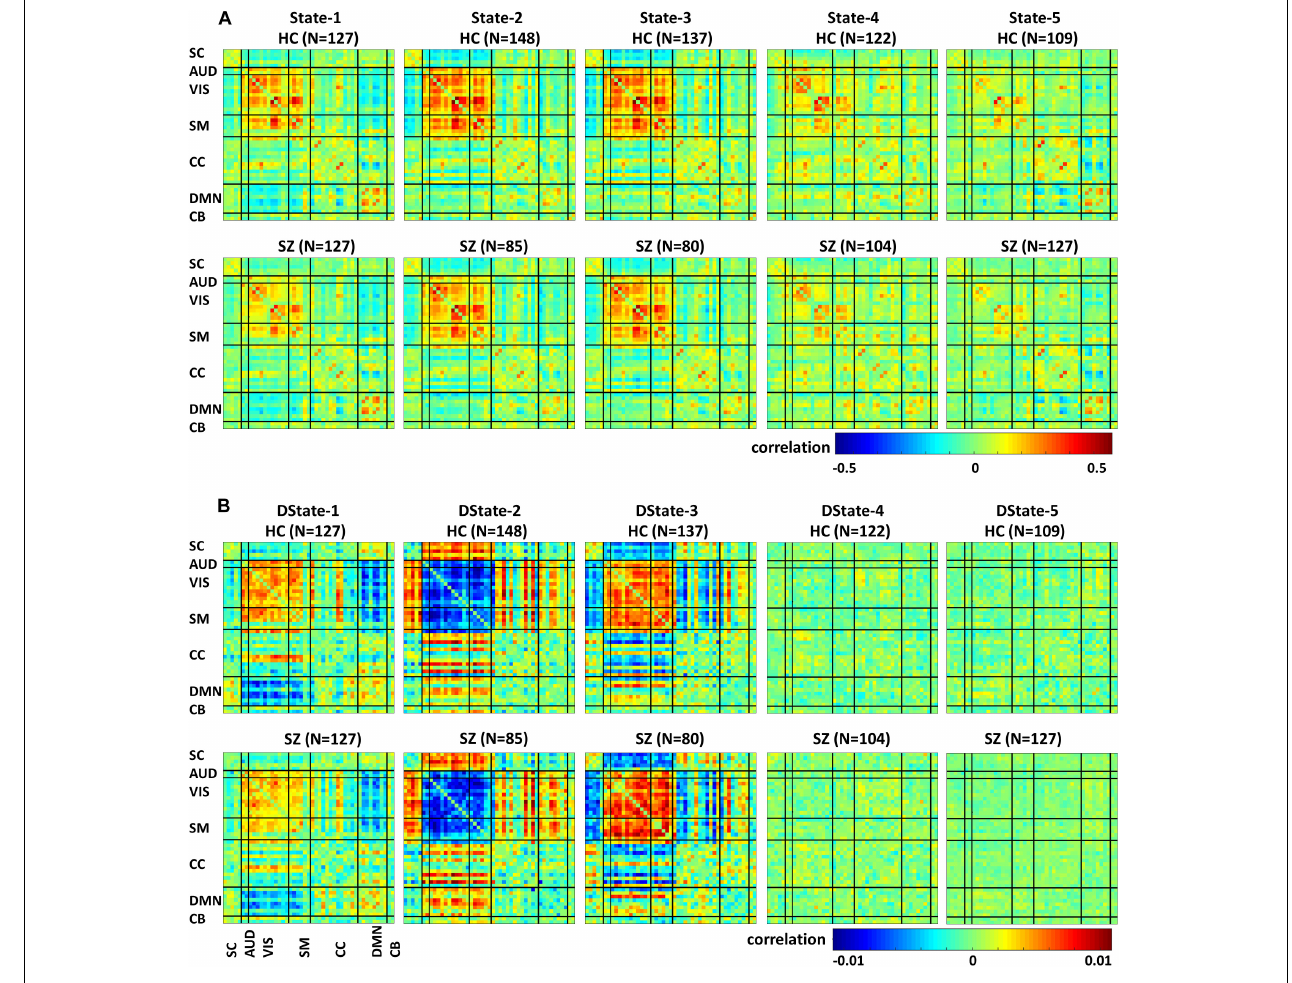
FIGURE 5 | Healthy control (HC) and schizophrenia (SZ) participants’ functional Network connectivity states (A) and their derivatives (B)